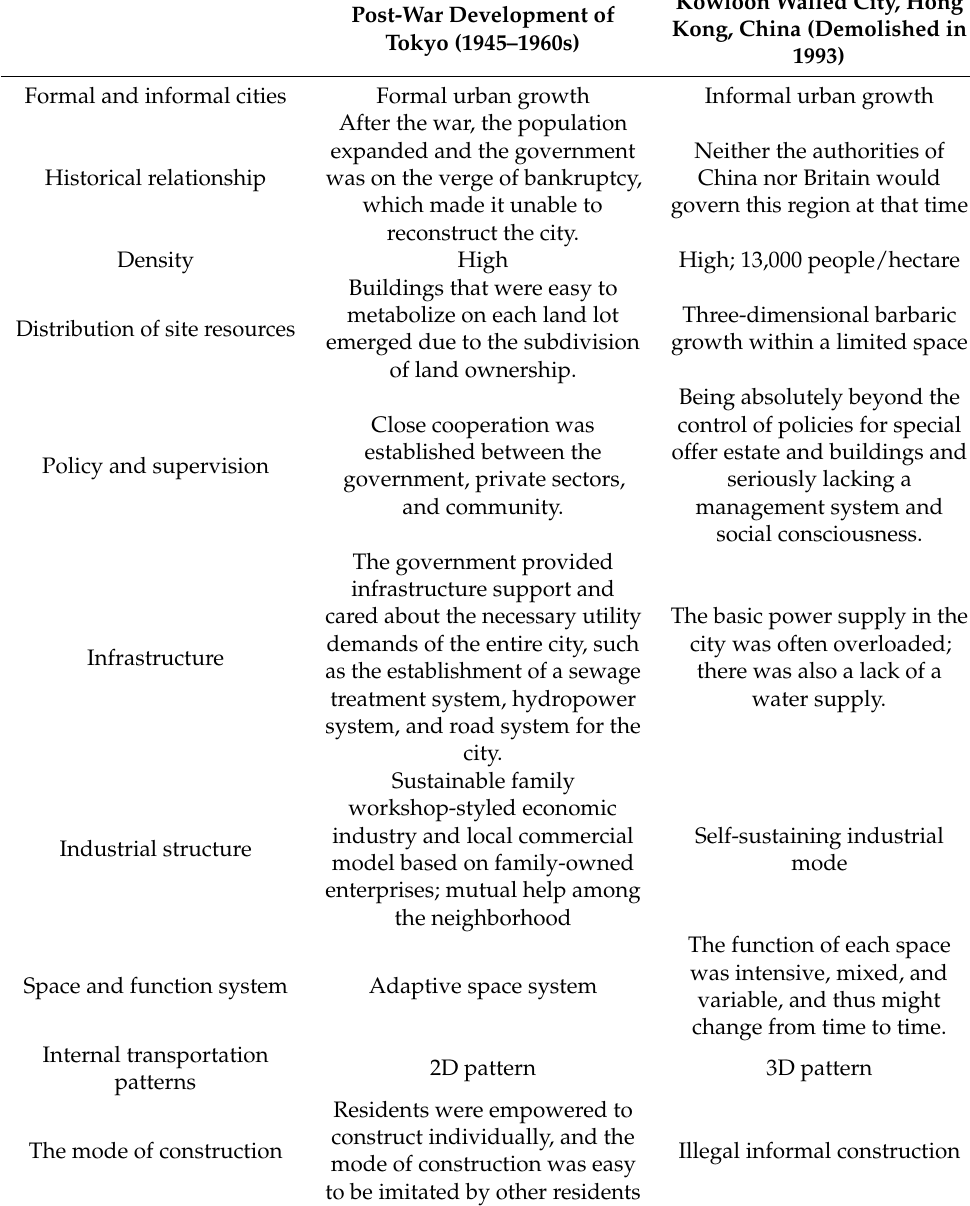
Table 1. Case analysis and comparison of the growth models of Tokyo after the war and Kowloon Walled City in Hong Kong, China (Source: